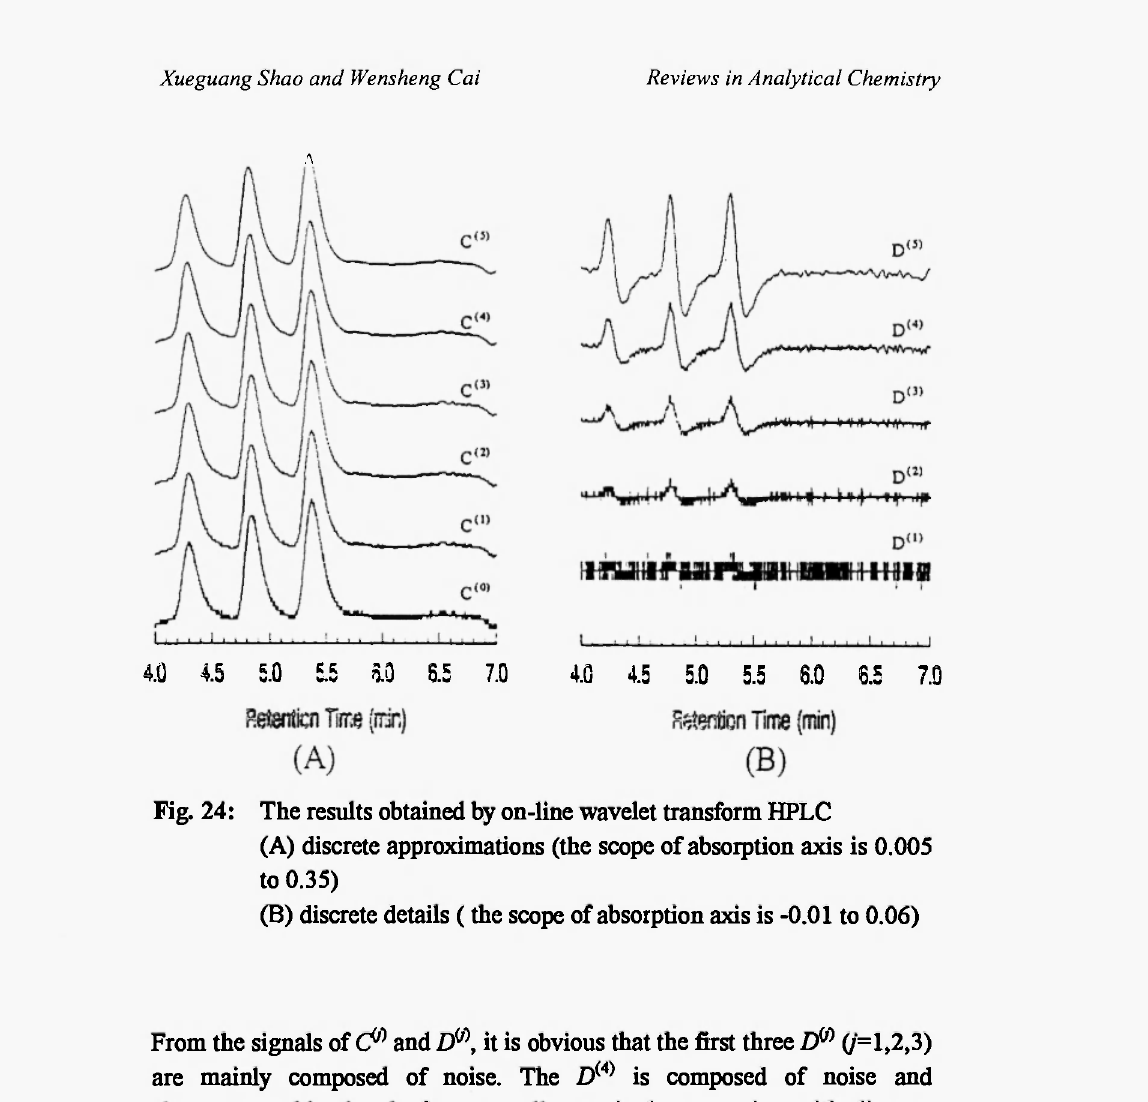
Fig. 24: The results obtained by on-line wavelet transform HPLC (A) discrete approximations (the scope of absorption axis is 0.005 to 0.35) (B) discrete details (the scope of absorption axis is -0.01 to